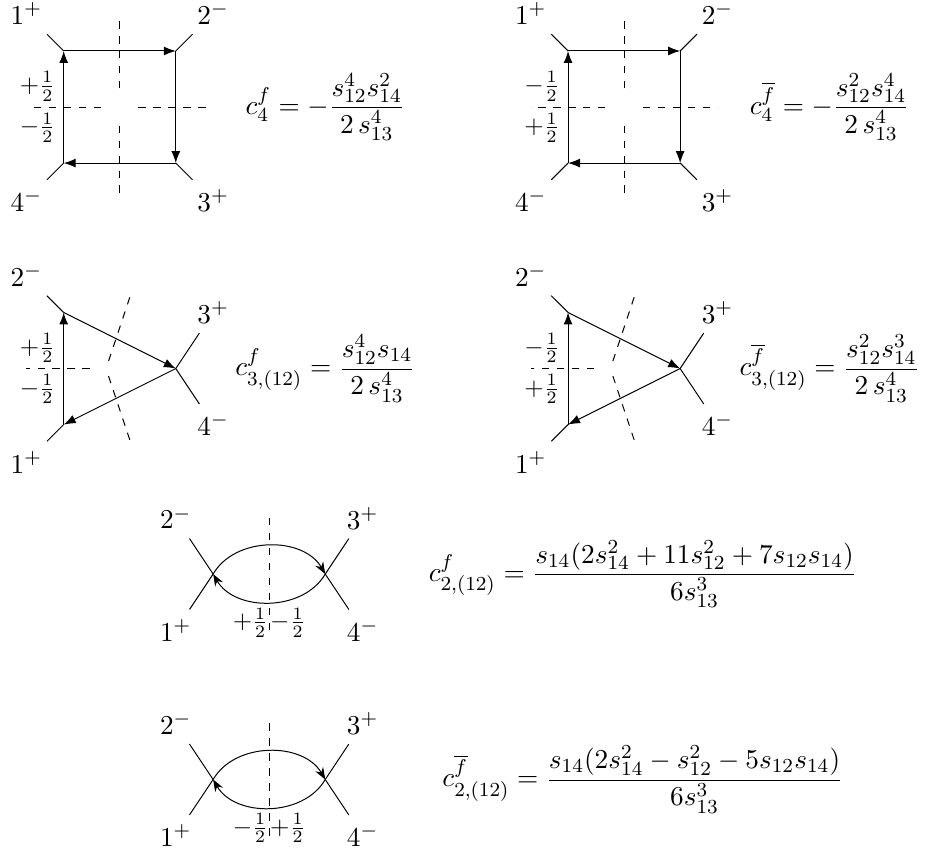
Figure 1 . Kinematic coefficients from generalised unitarity [125], here a kinematic contribution of the type h 24 i 2 [13] 2 s 12 s